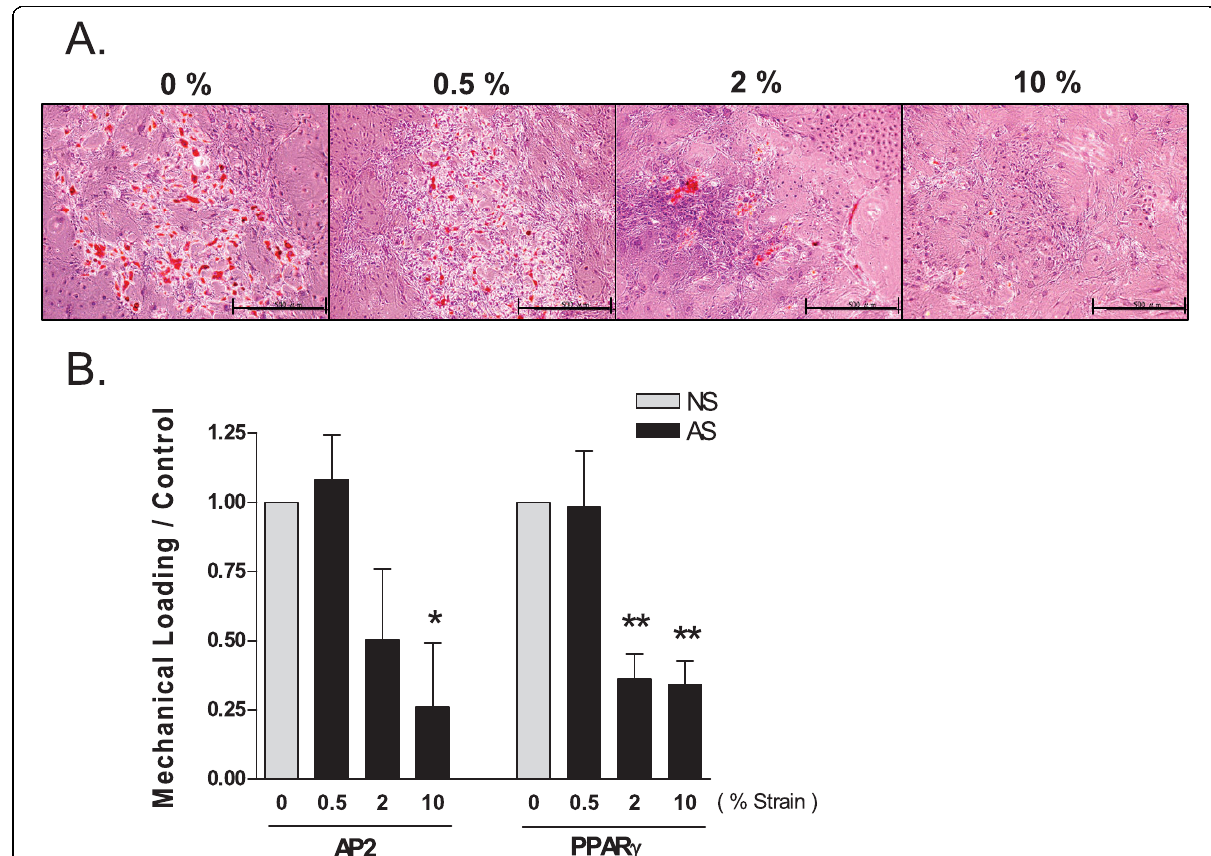
Figure 9 Strain-does dependent effect on adipogenesis in ADSCs . A . Oil-Red O staining of adult ADSCs that were subjected to AS of various strain magnitudes for the first 48 h and then adipogenic medium alone for the next 8 days. The non-strain cells (0%) were adipogenically induced for 10 days. Scale bars = 500 μ m. B . AP2 and PPAR g expression in ADSCs subjected to various AS as in A. The result shown was the expression levels normalized to b -actin and to the non-strain samples as in Figure 8. **: P < 0.01, *: P < 0.05, N = 3, compared ΔΔ CT to non- strain and 0.5% strain